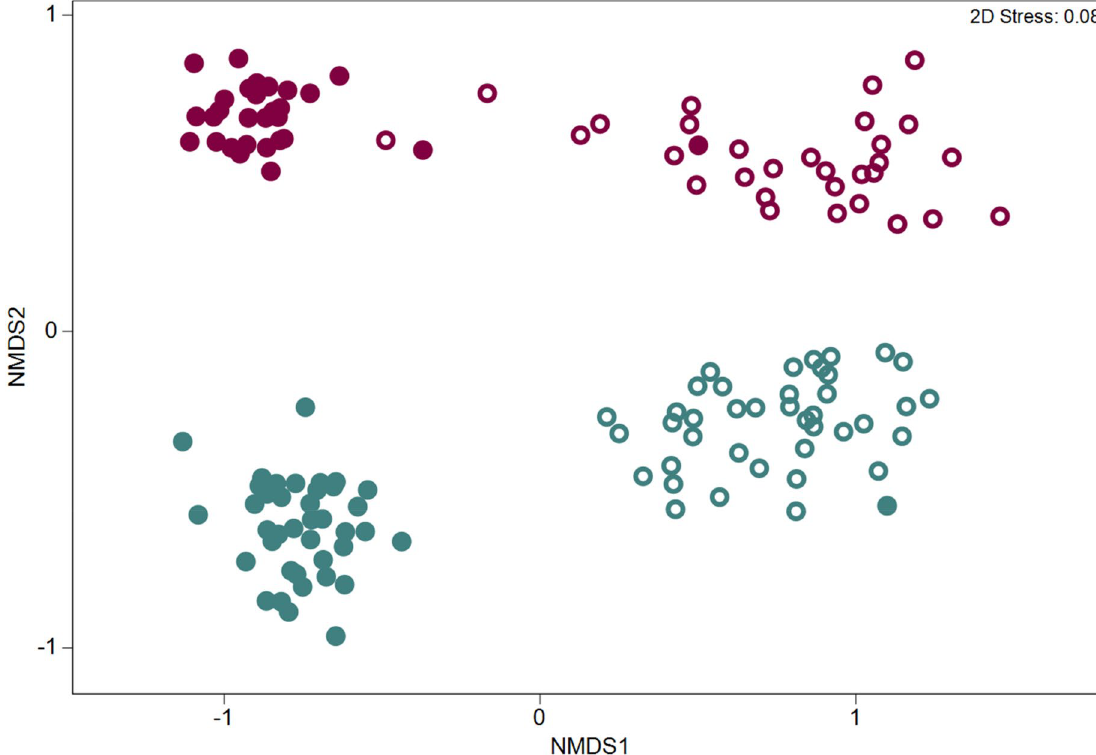
soil (filled symbols) in two pathogen trials inoculated or infested with Macrophomina phaseolina (blue) and Verticillium dahliae